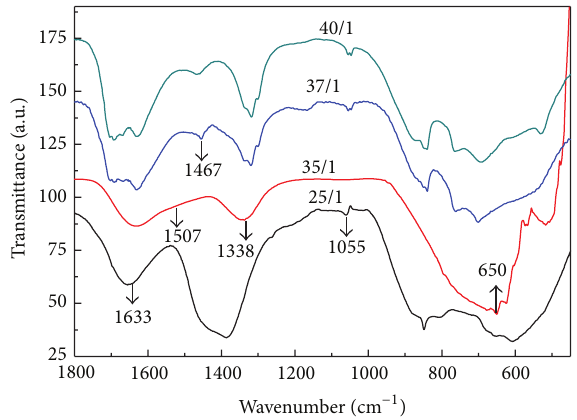
Figure 2: FTIR spectra of as-milled (K 0.5 Na 0.5 )NbO 3 prepared mechanochemically at 600 rpm for 5 h with different ball-to-powder mass ratios of 25/1, 35/1, 37/1, and